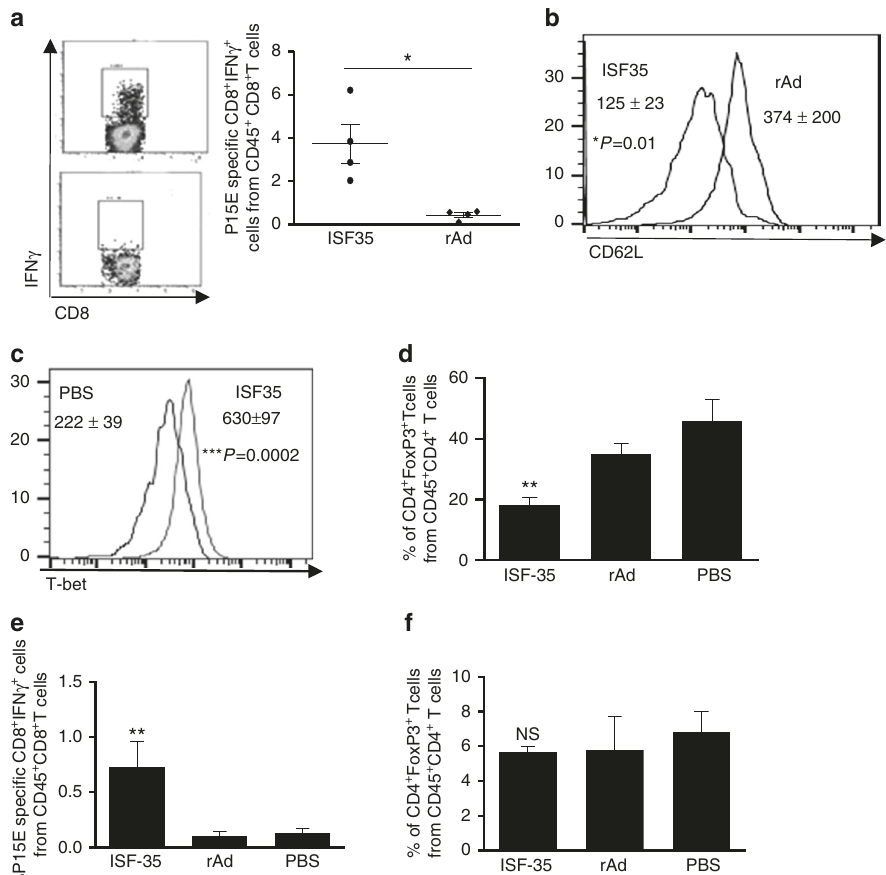
Fig. 2 Induction of tumor-speci fi c CD8 + T cell immunity and reduction of regulatory CD4 T cells through intratumoral ISF35 treatment. Mice bearing 8-day s.c. B16.F10 tumors were treated as indicated every 4 days and analyzed 9 days after initiation of treatment. a Tumor antigen (p15E)-speci fi c IFN- γ - producing CD8 T cells in TIL. Percent of CD8 + IFN- γ + cells (left) and cumulative data (right). b CD62L. c T-bet expression (MFI) in CD8 + T cells. d Percentage of CD4 Treg from CD45 + CD4 + T cells in tumor. e Tumor-speci fi c CD8 T cells and f Tregs in spleen. Data are representative of at least 2 independent experiments and analyzed by unpaired two-tailed t test or one-way ANOVA ( n = 4 or 5 mice/group). * P < 0.05, ** P < 0.005 and *** P < 0.0005. Error bars are